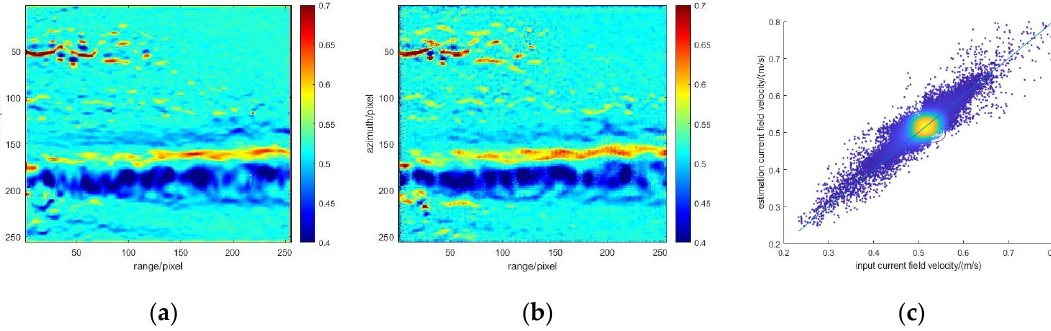
Figure 13. The velocity calculation results based on the iterative method: ( a ) the input velocity, ( b ) the iterative current velocity, and ( c ) the scatter density map of the input and calculated current velocities.